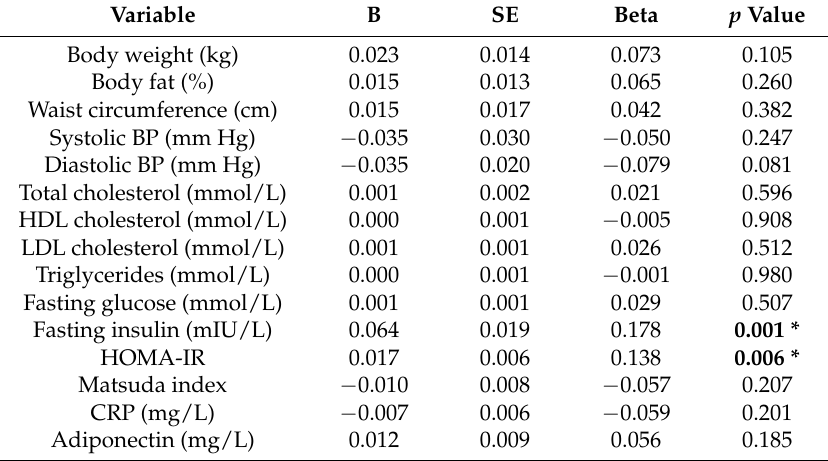
Table 6. Regression coefficients (B), their standard error (SE) and the standardized regression coefficients (Beta) for the associations between changes in anthropometric variables, blood pressure, and metabolic factors during the weight maintenance phase and total meat protein intake 1